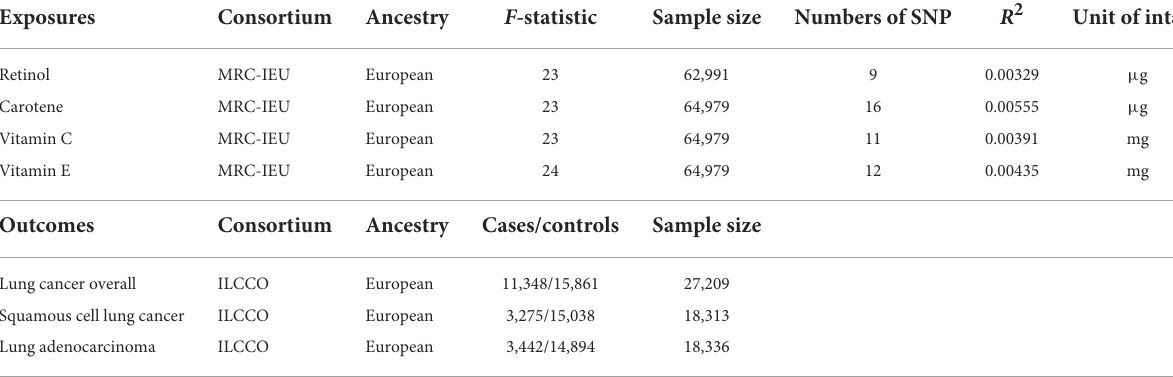
TABLE 1 Characteristics of antioxidant vitamins and lung cancer datasets.